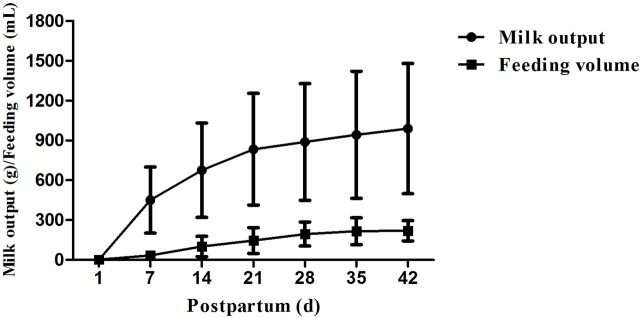
Milk output and feeding volume on days 7, 14, 21, 28, 35 and 42 (all P < 0.001).